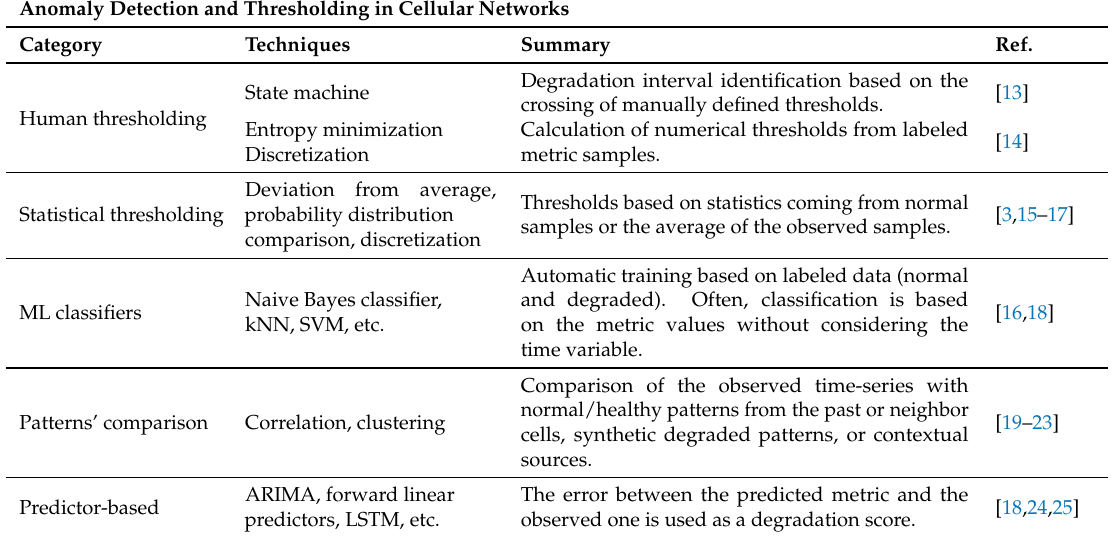
Table 1. Summary of key related works on anomaly